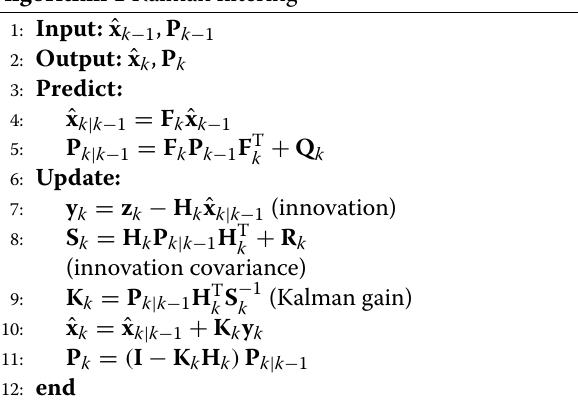
Algorithm 1 Kalman